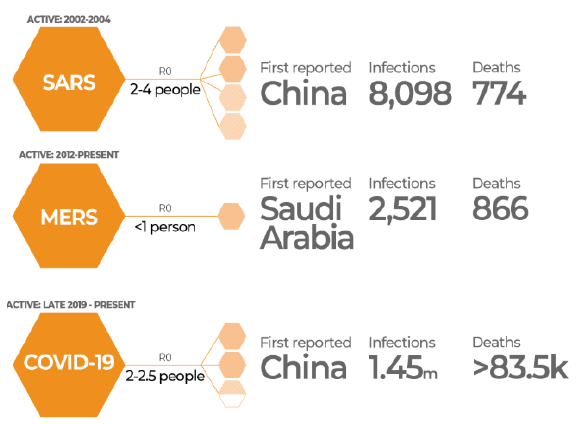
Figure 2 : Coronavirus outbreak